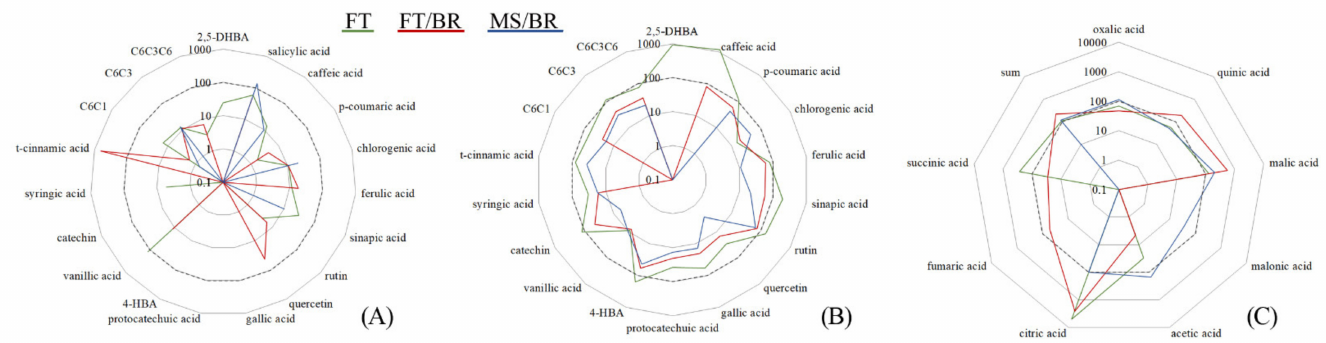
Figure 5. Percentage change of biochemical and physiological parameters of leaves ( A ) and roots ( B , C ) of Paulownia plants cultivated in waste materials (FT—flotation tailings, FT/BR—flotation tailings supplemented with biochar, MS/BR—mining sludge supplemented with biochar) in relation to control plants. For undetected compounds, the detection limit was used for calculations as a minimal detectable amount. Only significant differences were present at α = 95% (2,5-DHBA— 2,5-dihydroxybenzoic acid, 4-HBA—4-hydroxybenzoic acid, C6-C1—hydroxybenzoic acids, C6-C3—phenylopropanoids, C6-C3-C6—flavonoids, sum—a sum of low-molecular-weight organic acids